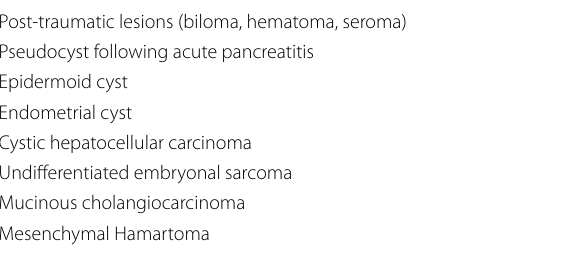
Table 1 Other cystic lesions that could be evocated